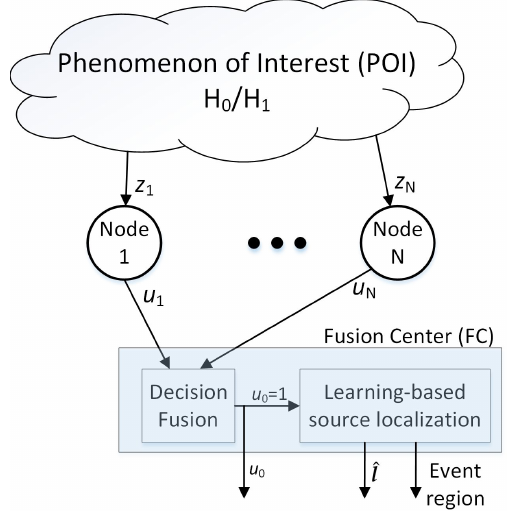
Figure 1. The network configuration studied in this paper. The network nodes observe a common phenomenon of interest and decide locally about event occurrence. Then, they send their decisions to FC where the final decision u 0 is taken. If u 0 = 1, FC gives an estimation of source location ˆ l and its